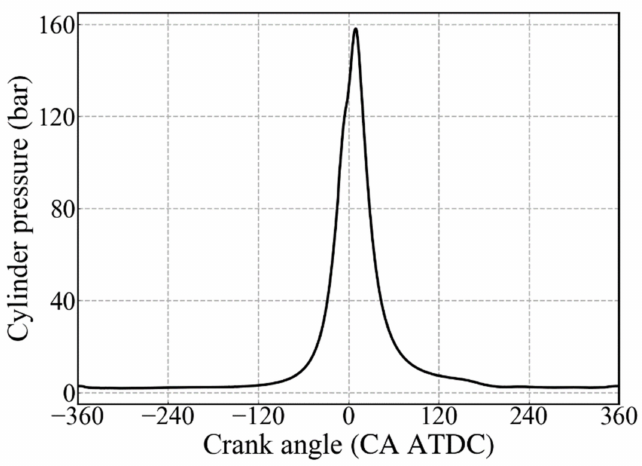
Figure 2. In-cylinder